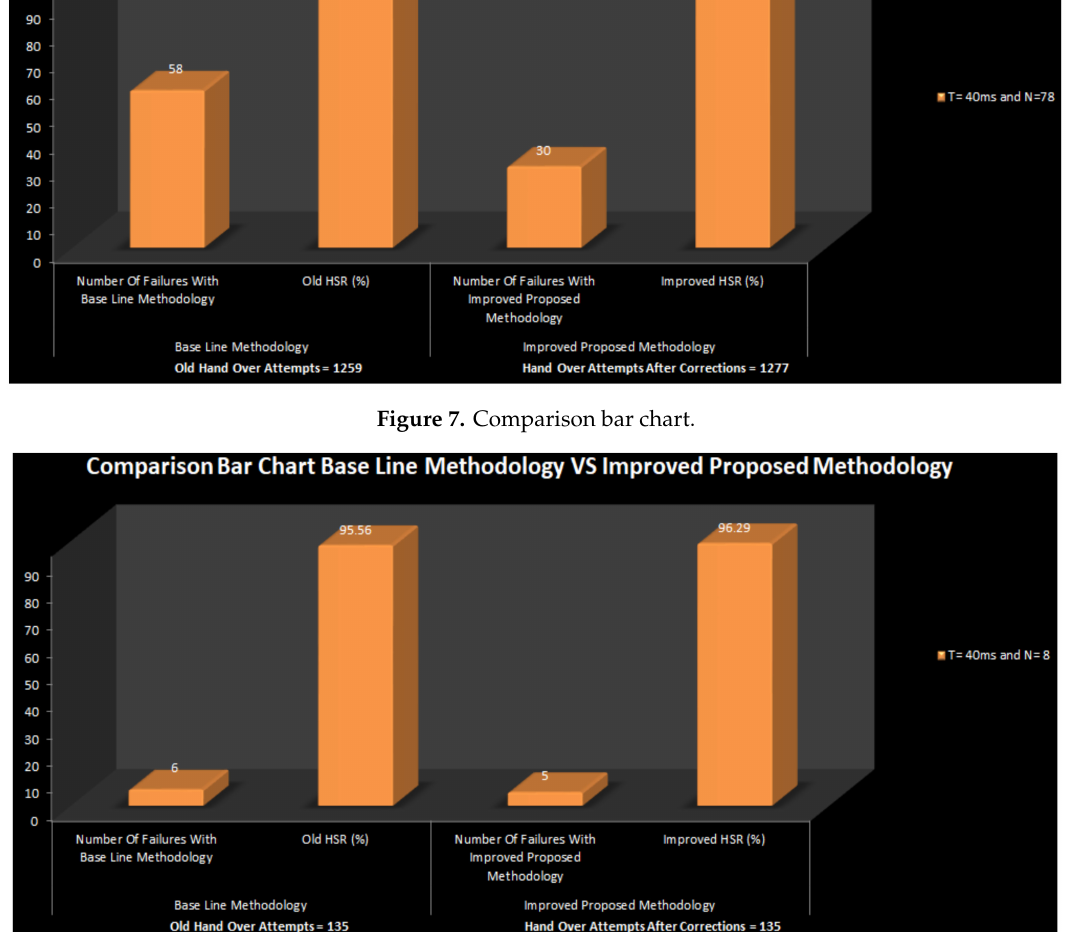
Figure 8. Comparison bar chart.